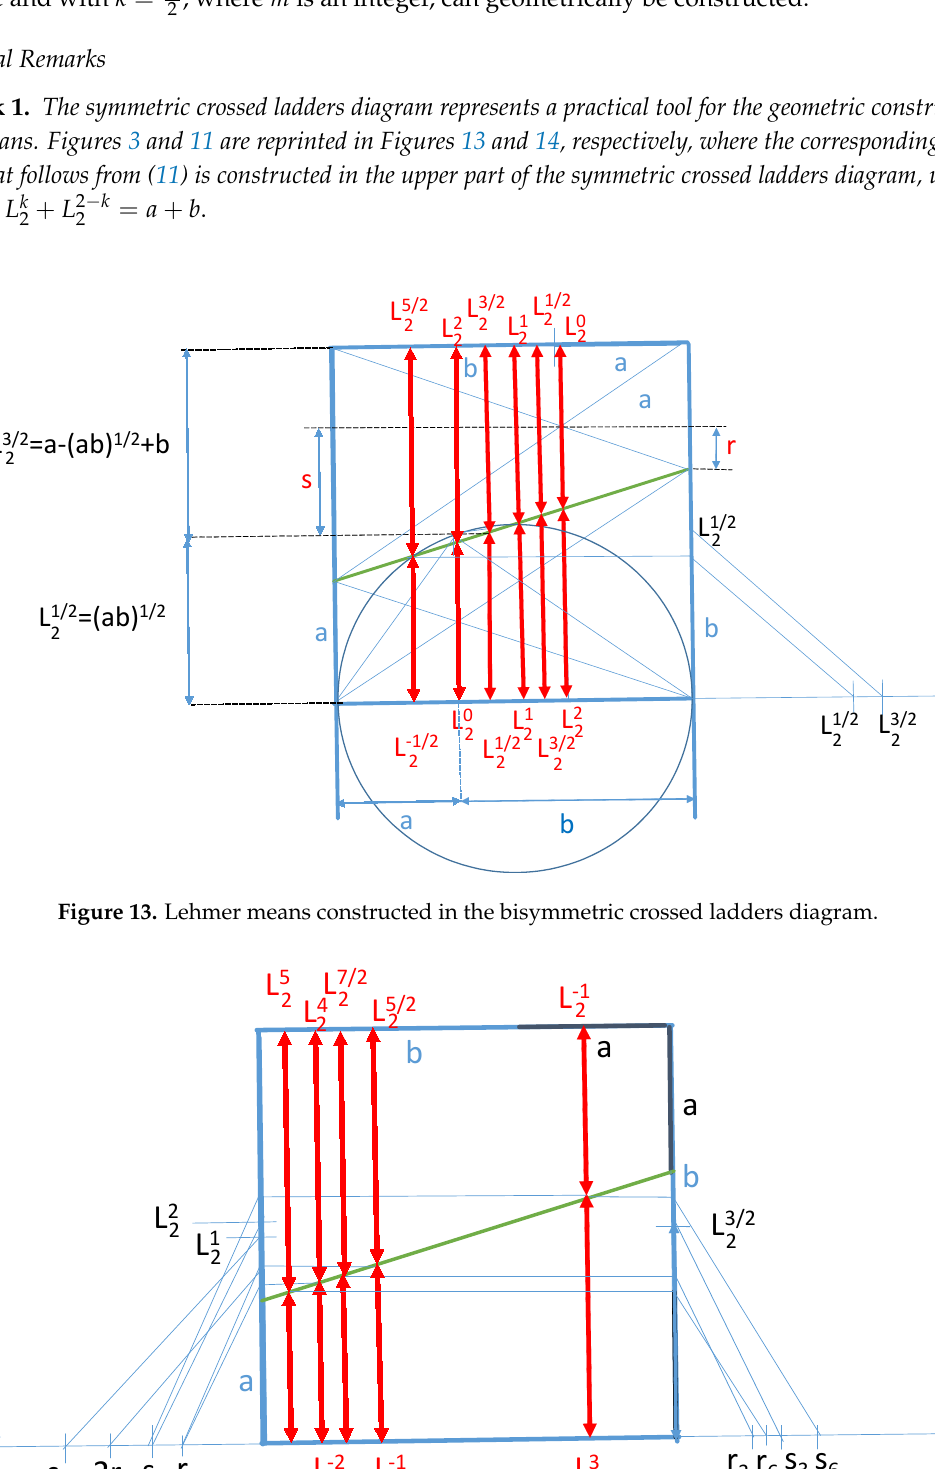
Figure 14. Lehmer means constructed in the bisymmetric crossed ladders Figure 14: Lehmer means constructed in the bisymmetric crossed ladders diagram.